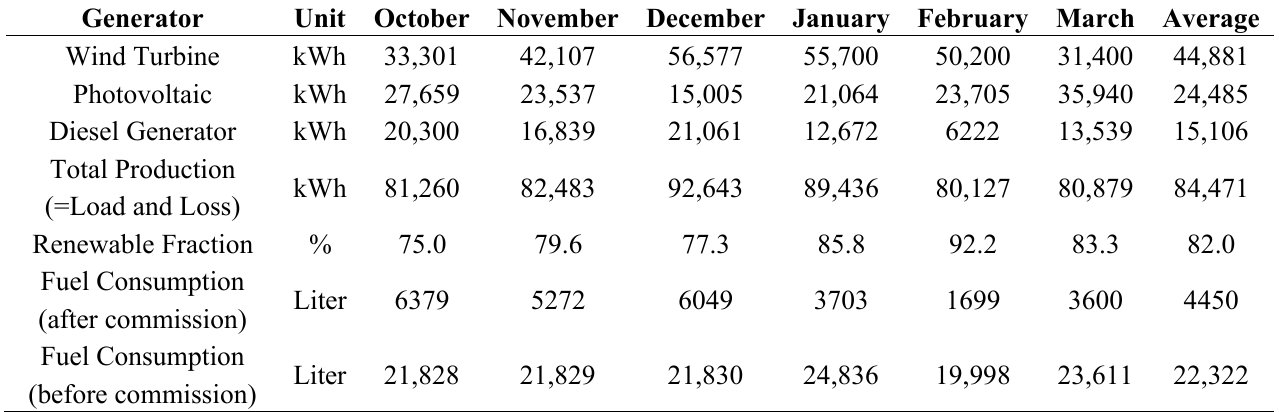
Table 7. Energy production and load of the test island after